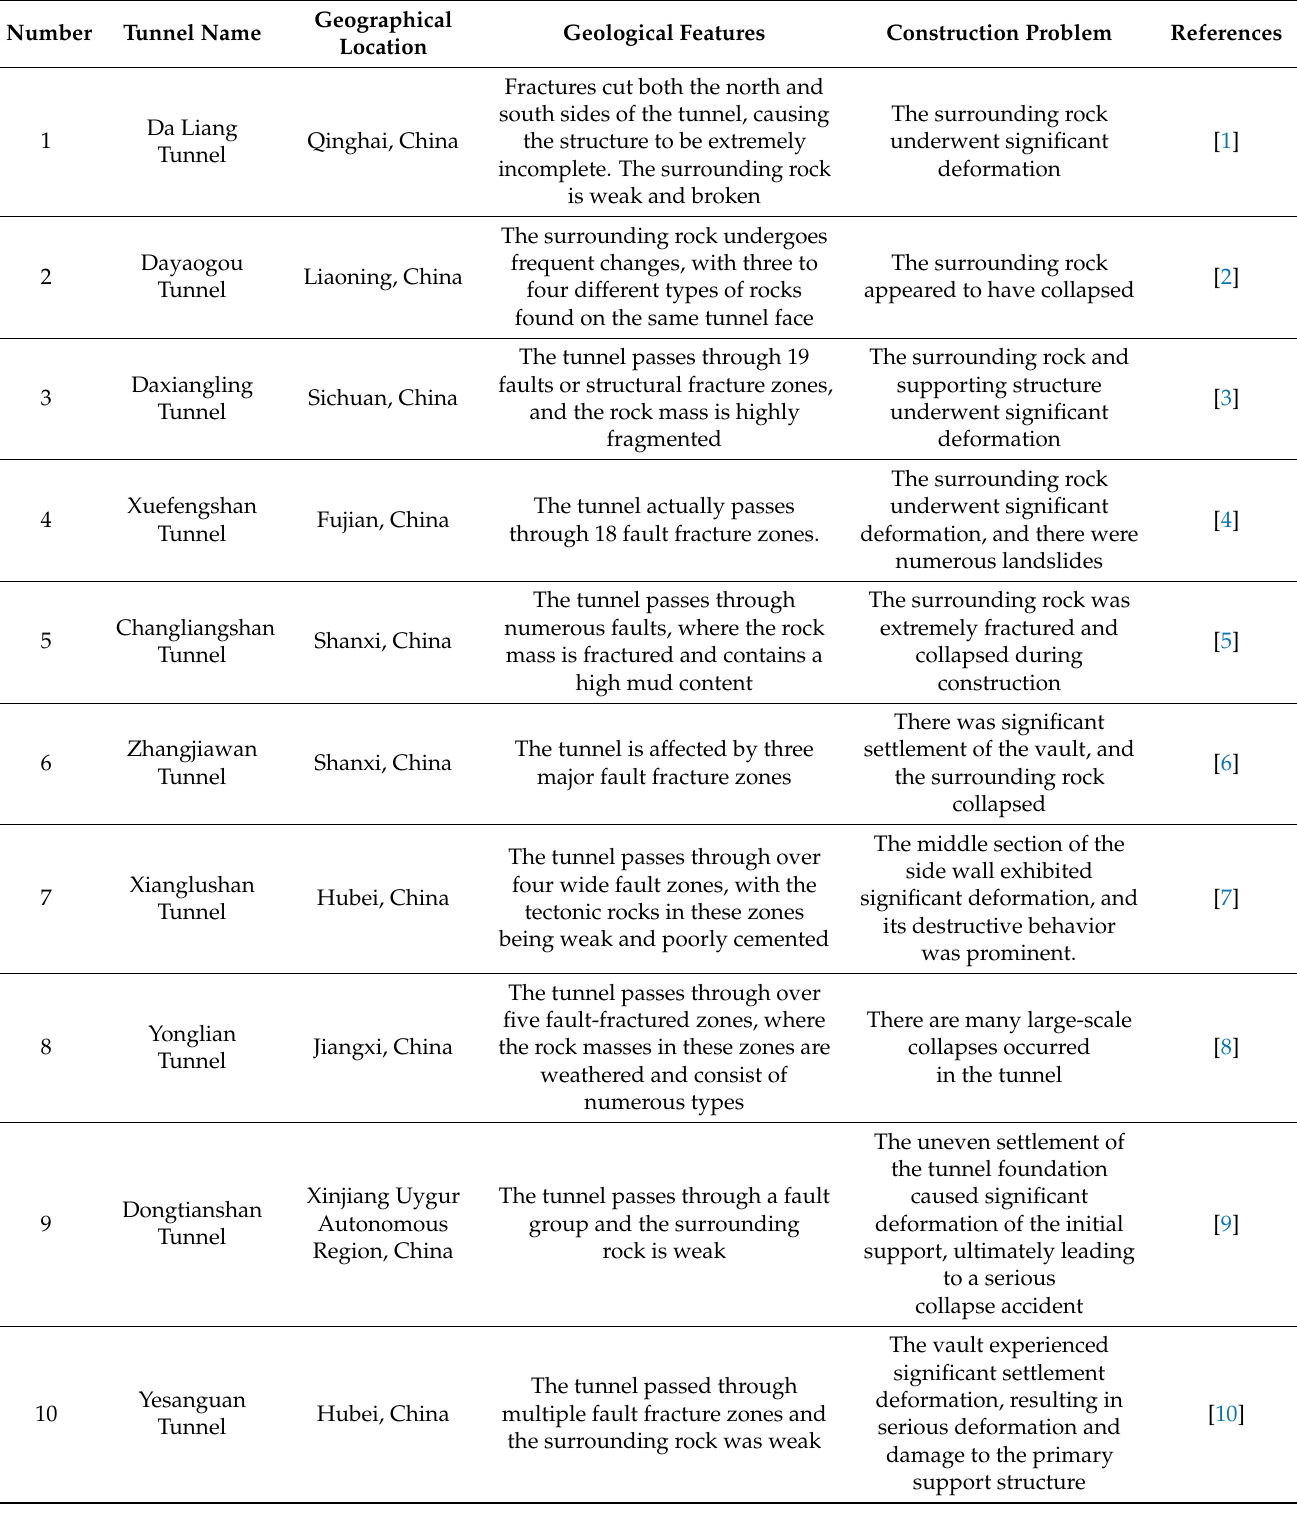
Table 1. Statistical table of tunnel fault fracture zone